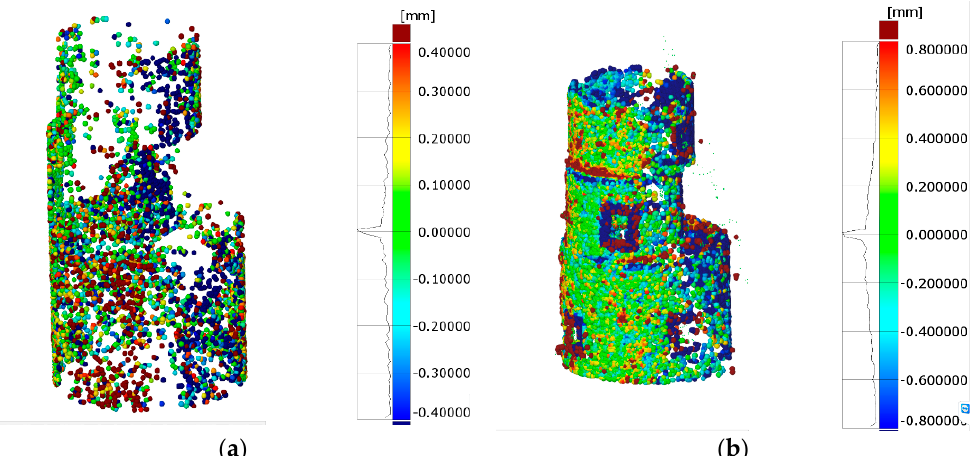
Figure 13. 3D representation of measured part in lab environment with targetless orientation approach: ( a ) surface point comparison against reference mesh with sparse point cloud; and ( b ) surface point comparison against reference mesh with dense point cloud (quarter resolution).